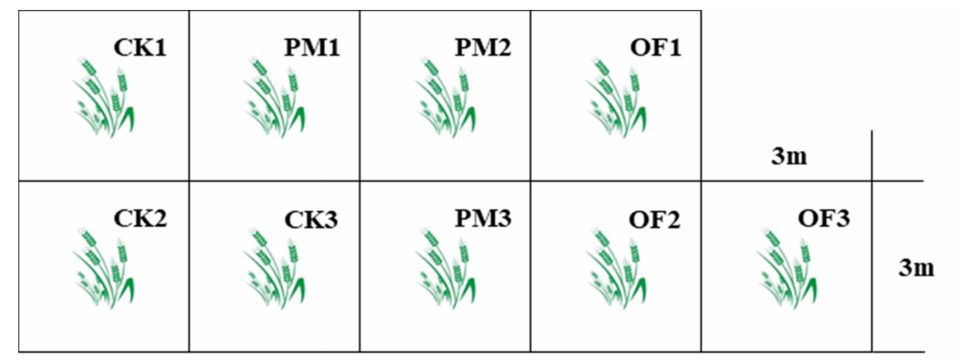
Figure 1. Experimental site